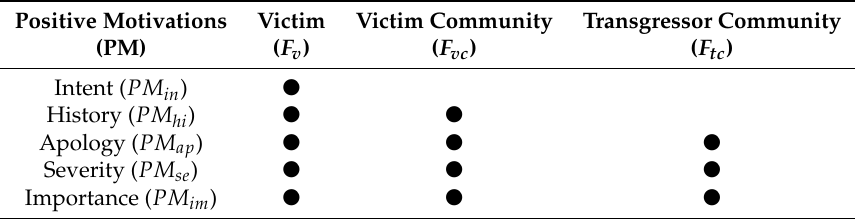
Table 1. Positive motivations for evaluating forgiveness from the viewpoints of different forgiveness sources